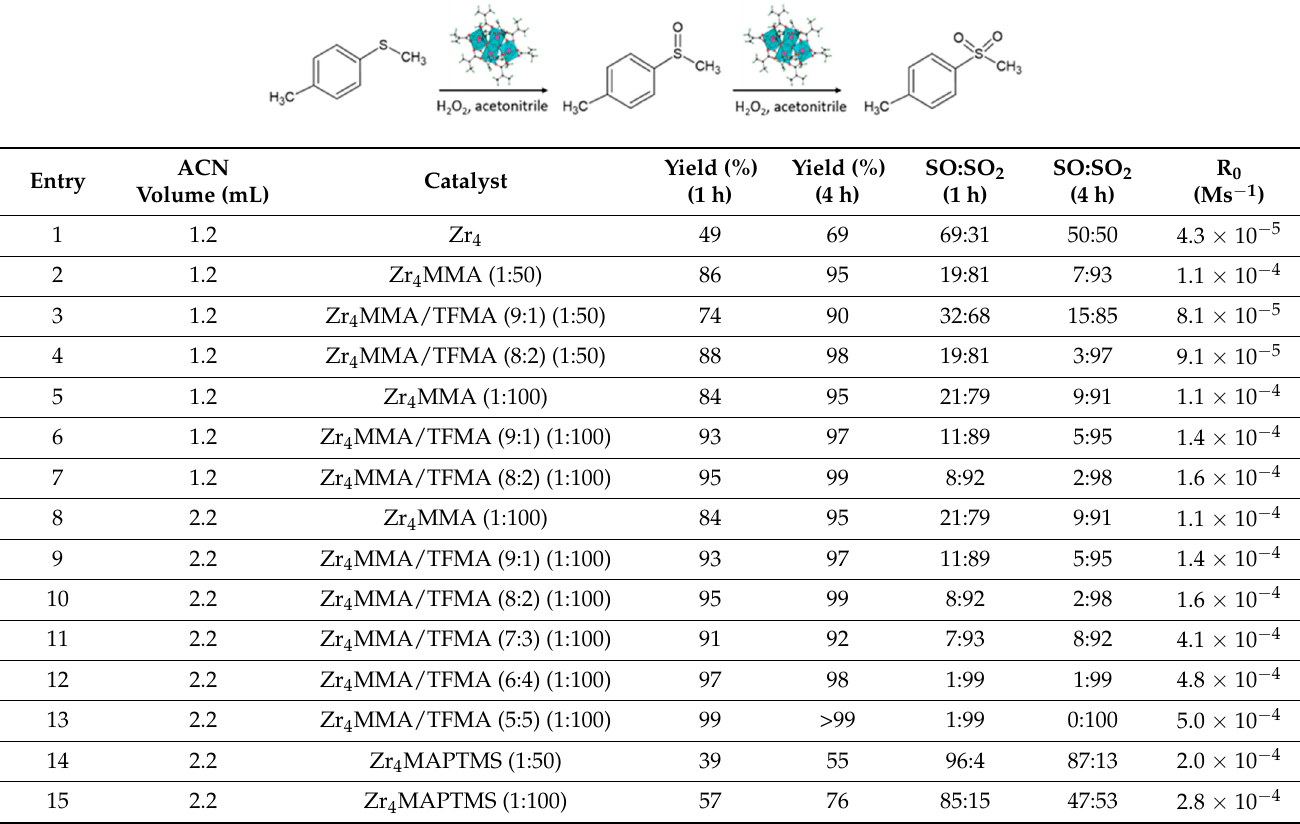
Table 4. Catalytic performances of the hybrids under more concentrated conditions (0.66 M methyl p-tolyl sulphide, 1.37 M H 2 O 2 and 1.2 mL of ACN) and less concentrated conditions (0.40 M methyl p-tolyl sulphide, 0.81 M H 2 O 2 and 2.2 mL of ACN). Substrate: 1 mmol, oxocluster 0.28–0.29% mol, 2 mmol of H 2 O 2 (from a 35% wt. aqueous solution); T = 50 °C. A general scheme of the catalytic oxidation is reported below.